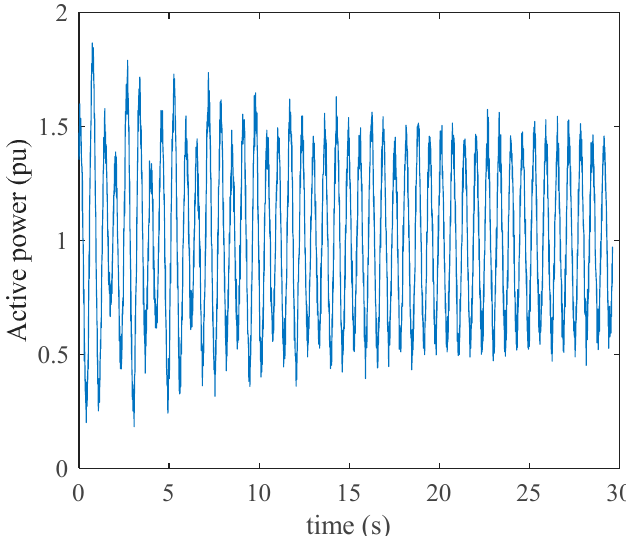
Figure 8. Active power oscillation with the frequency of 1.55 Hz of ZTS generator in Zhejiang Province, which is successfully identified as natural oscillation by the proposed method.